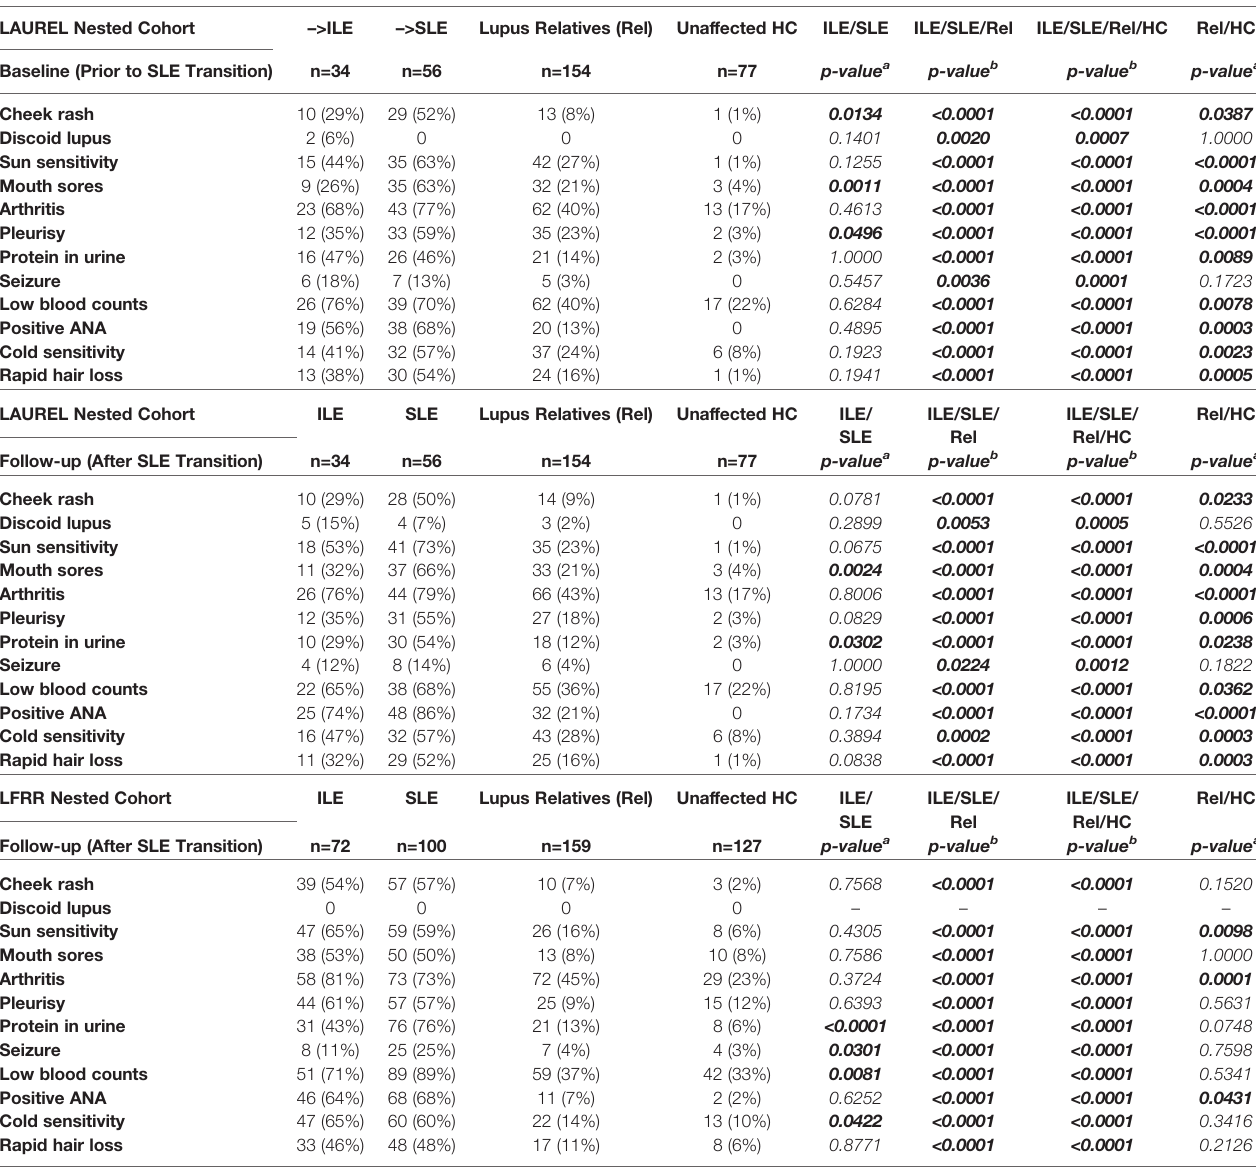
TABLE 6 | SLE-CSQ Components in Lupus Relatives Who Transition to ILE or SLE. LAUREL Nested